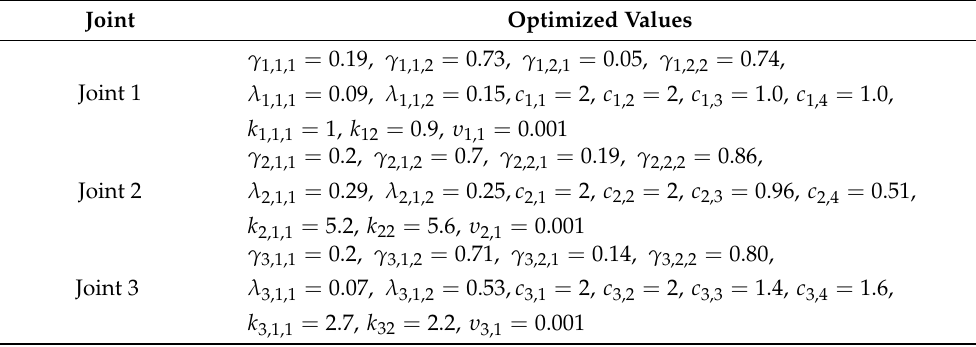
Table 1. Optimized values of the parameters of the controller via